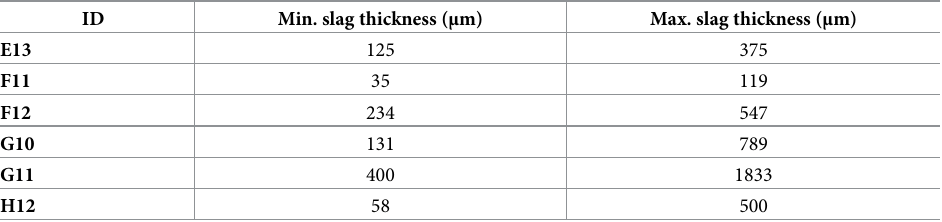
Table 8. Thicknesses of the slag